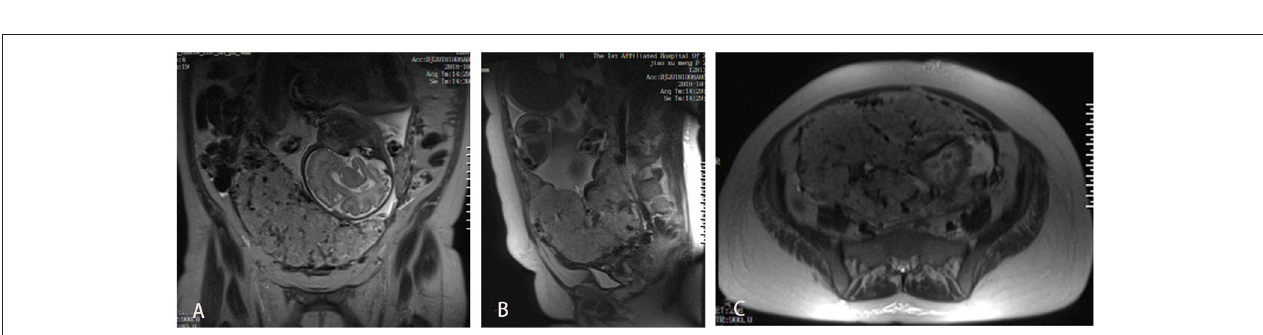
FIGURE 1 | Ultrasonograms of the participant. (A) Increased placental thickness under preoperative ultrasound examination; (B) Loss of hypoechoic retroplacental zone and numerous large and irregular lacunae in the placenta; (C) Absence of the lower muscle layer of uterus and Vessels with high velocity blood flow leading from the myometrium into the placental lacunae; (D) Striking amount of color Doppler signal seen between the myometrium and the posterior wall of the bladder.